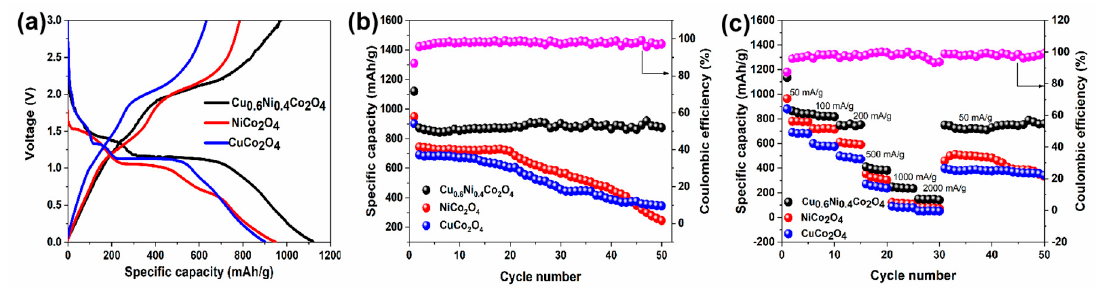
Figure 7. Electrochemical tests of the three samples: ( a ) Initial charge and discharge curves profiles for NiCo 2 O 4 , CuCo 2 O 4 , Cu 0.6 Ni 0.4 Co 2 O 4 at the current of 50 mA g − 1 between 0.01 and 3 V (vs. Li + /Li). ( b ) Cycling performance of the three powders at a current of 50 mA g − 1 . ( c ) Capacity rate performance of the anode materials.